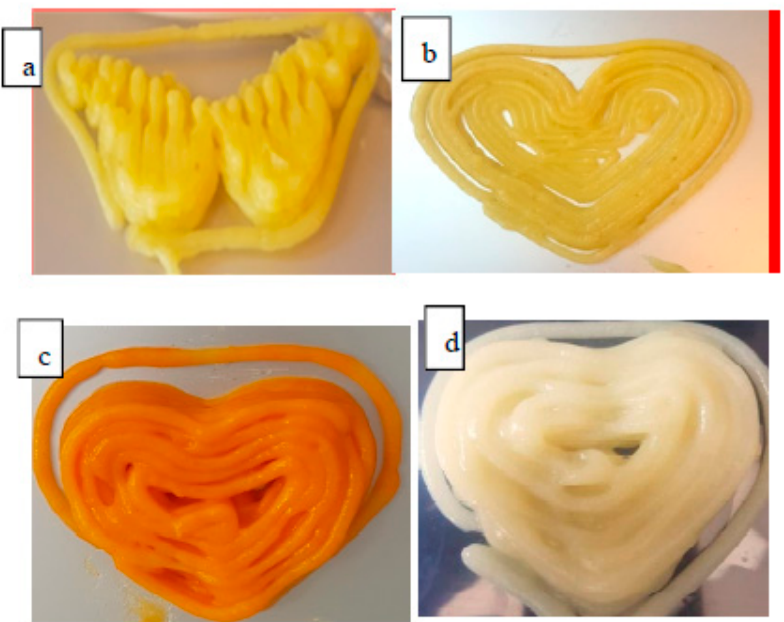
Figure 4. Printed products of microwaved potato with ( a ) 1% alginate, ( b ) 1% butter, ( c ) 1 / 3 carrots, and ( d ) boiled potato with 1% butter.